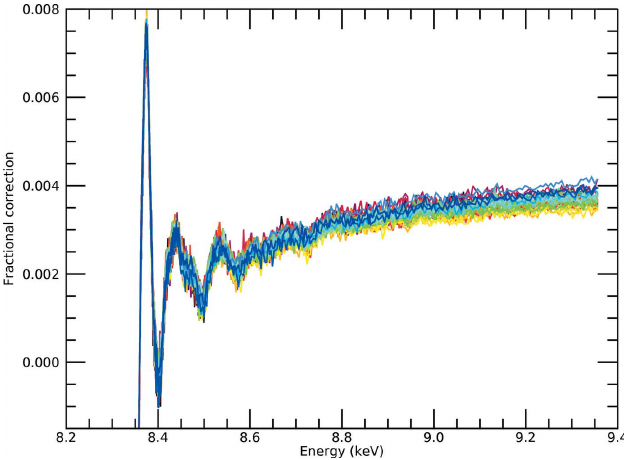
Figure 8 Fractional correction after second-order Taylor expansion correction [equation (8)] for the i -pr data set. This is very similar to the result of the first-order Taylor expansion in Fig. 7, and shows that the correction is now well converged. The difference from the previous figure is not easily visible by eye – the data have converged.